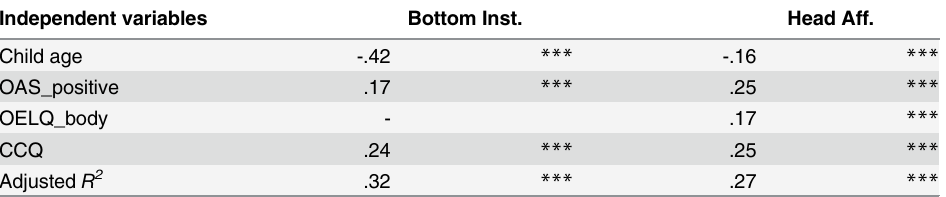
Standardized beta coef fi cients are shown. Abbreviations are the same as Table